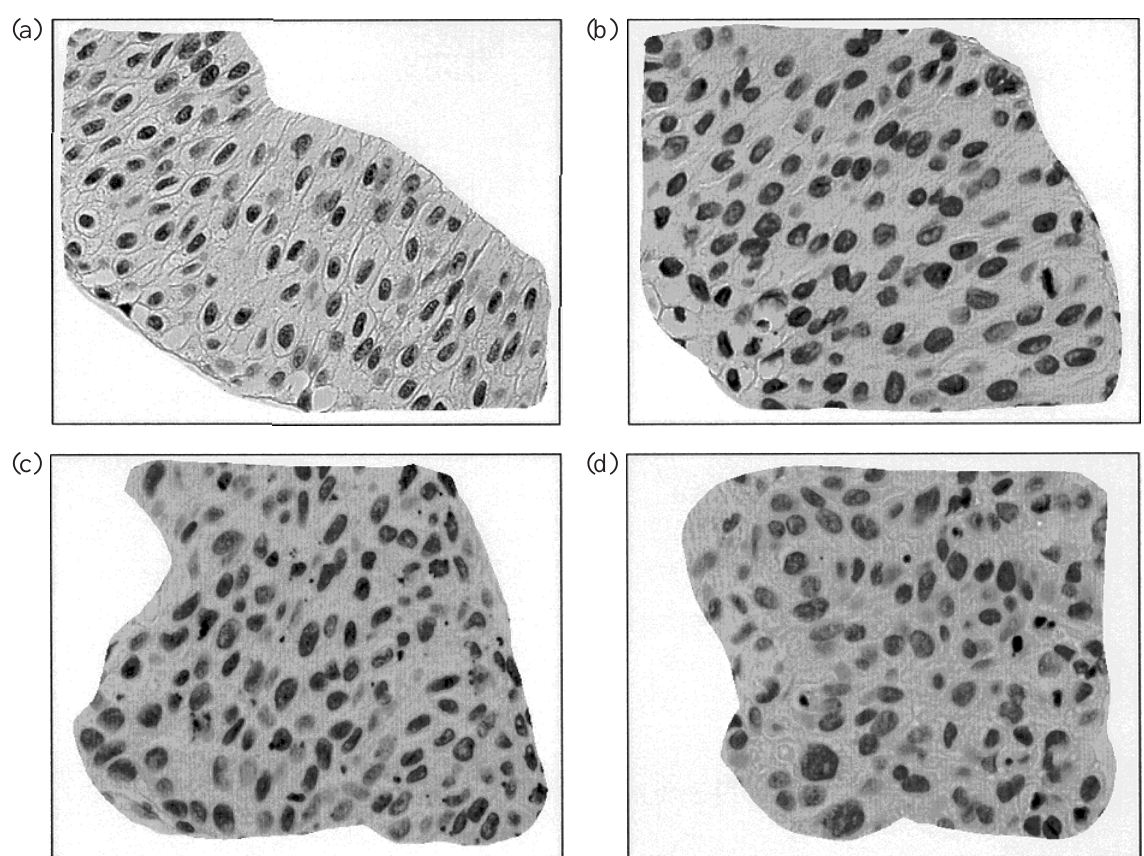
Fig. 1. Digital microscopic images (40 × ) of the bladder carcinoma cell stained by Feulgen. In each grade the region of interest was chosen by pathologists: (a) Grade 1, (b) Grade 2A, (c) Grade 2B and (d) Grade